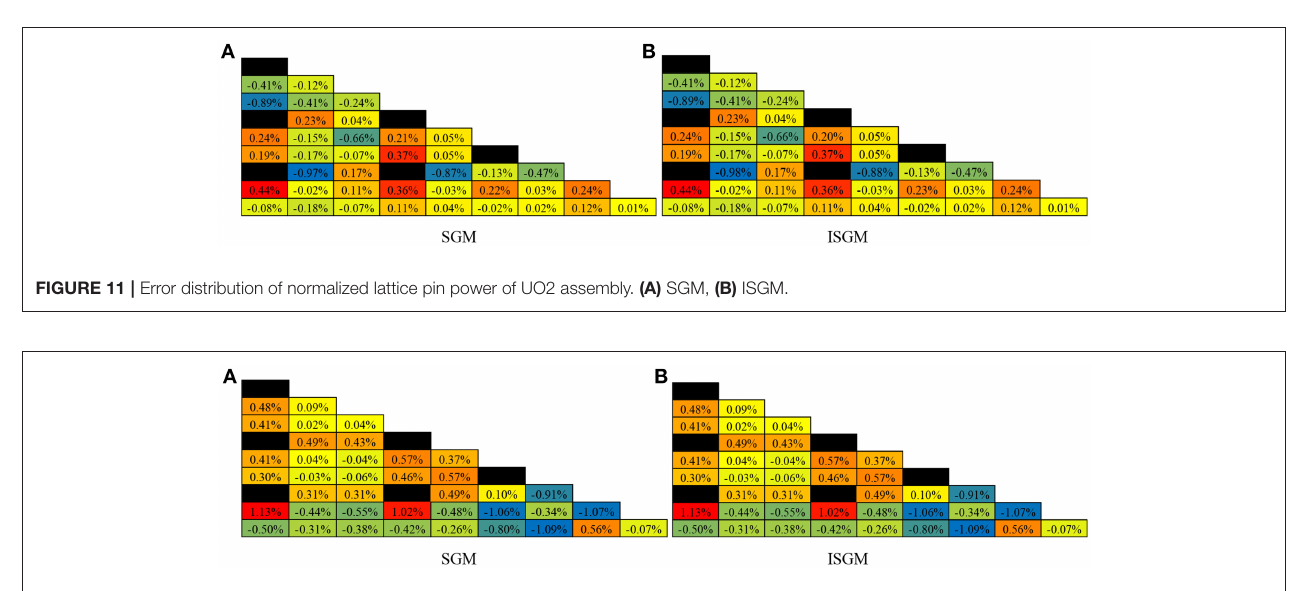
FIGURE 12 | Error distribution of normalized lattice pin power of MOX assembly. (A) SGM, (B) ISGM.